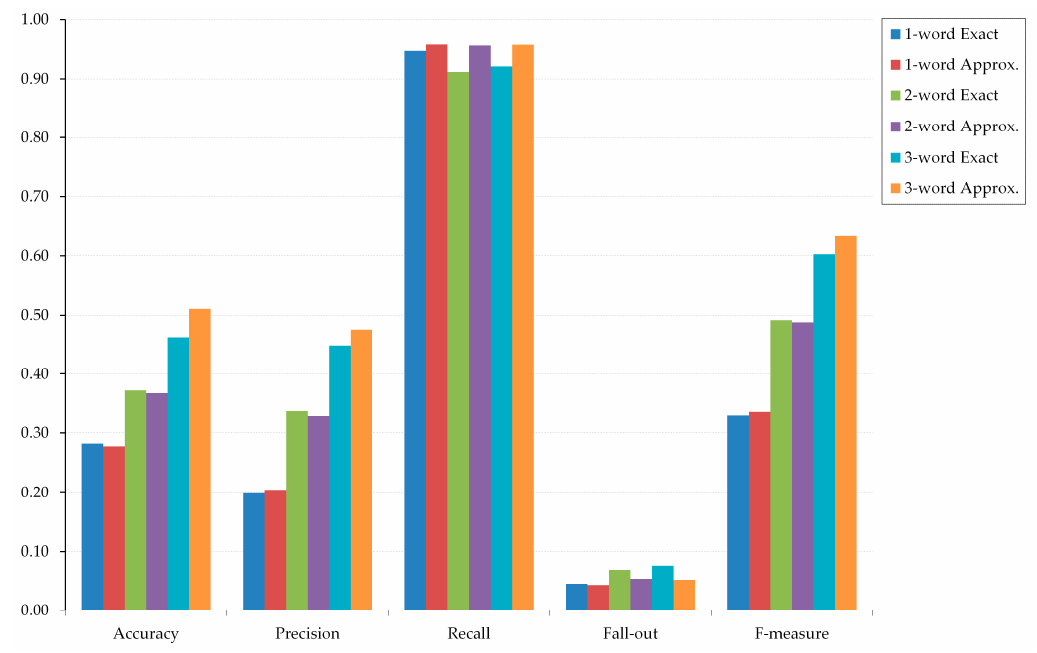
Figure 8. Comparison aggregated performance measures in retrieval optimized for recall.